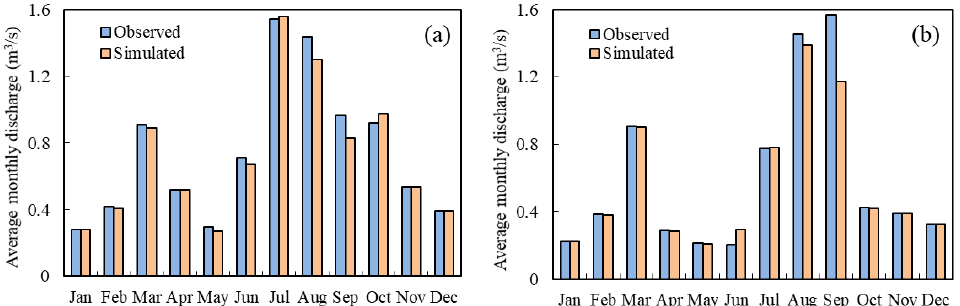
Figure 4. Comparison of average simulated and observed monthly runoff discharge for the two periods (( a ) the 1980s; ( b ) the 2010s).